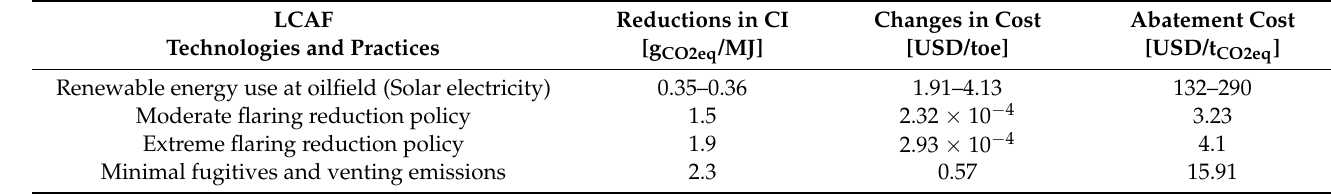
Table 2. Oilfield LCAF technologies and